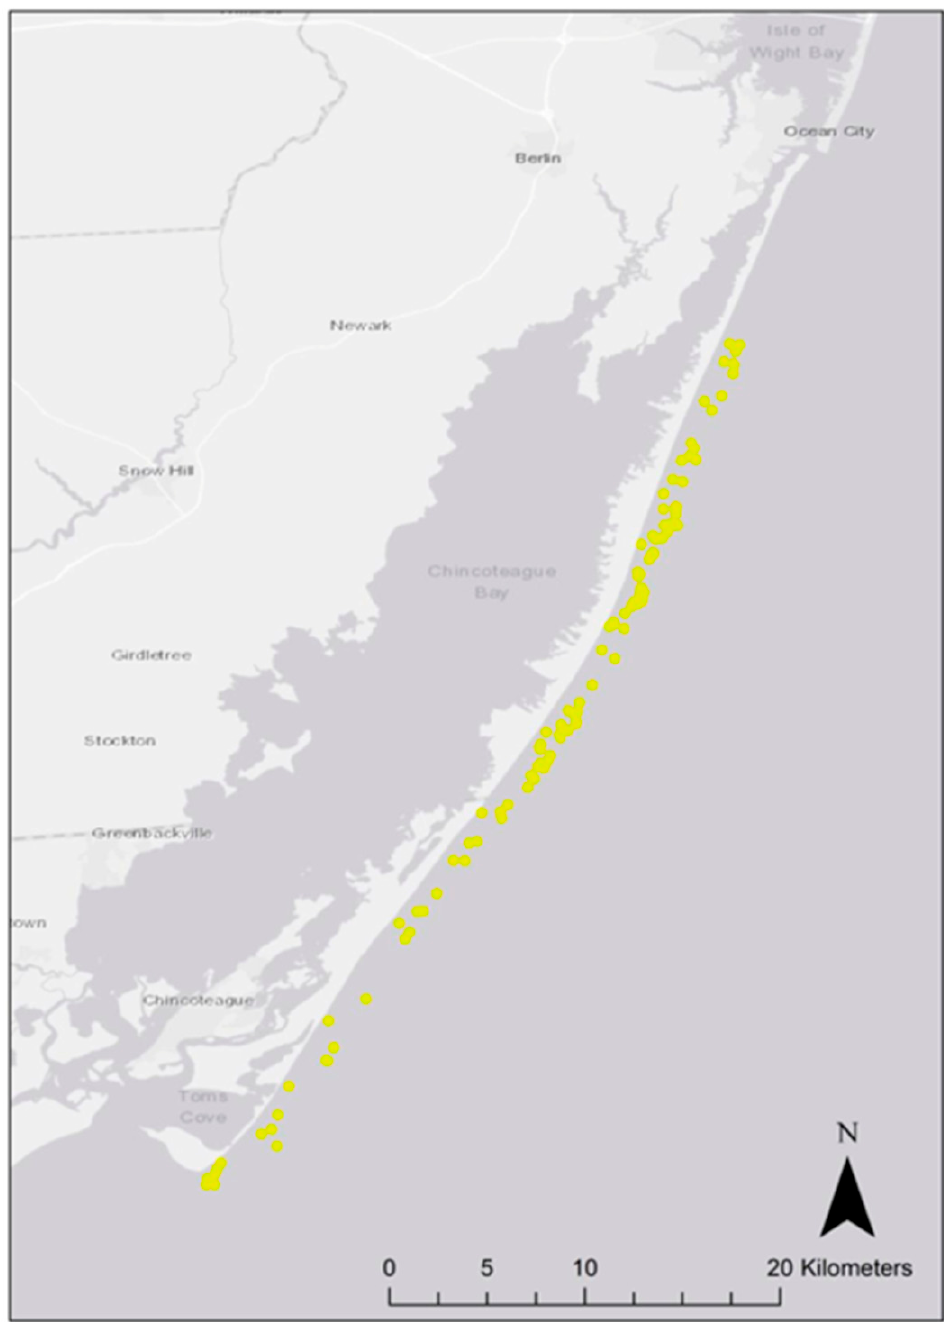
Figure 1. Pre-Sandy (2011) survey sites (n = 125) sampled in October 2011 on the beach (n = 15) and subtidally up to 1 km offshore (n = 110) of Assateague Island National Seashore, Maryland.